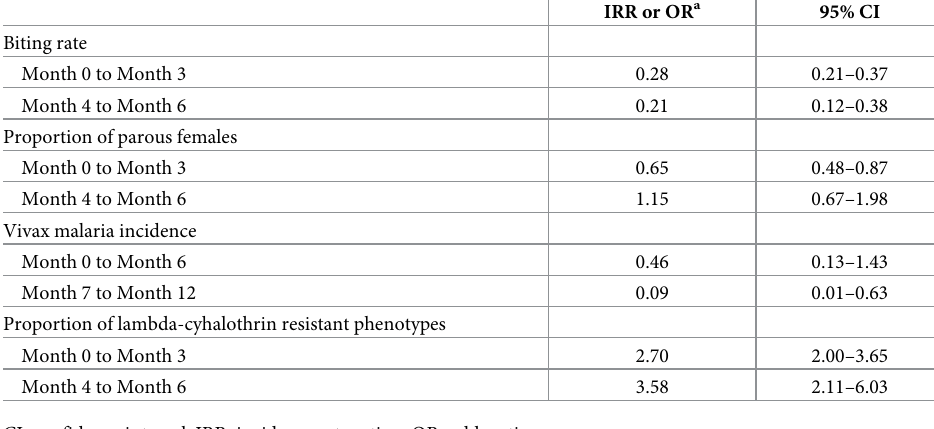
CI, confidence interval; IRR, incidence rate ration, OR, odds ratio. a Coefficient estimate for the interaction term between the ORS group and the follow-up period, considering the control as the